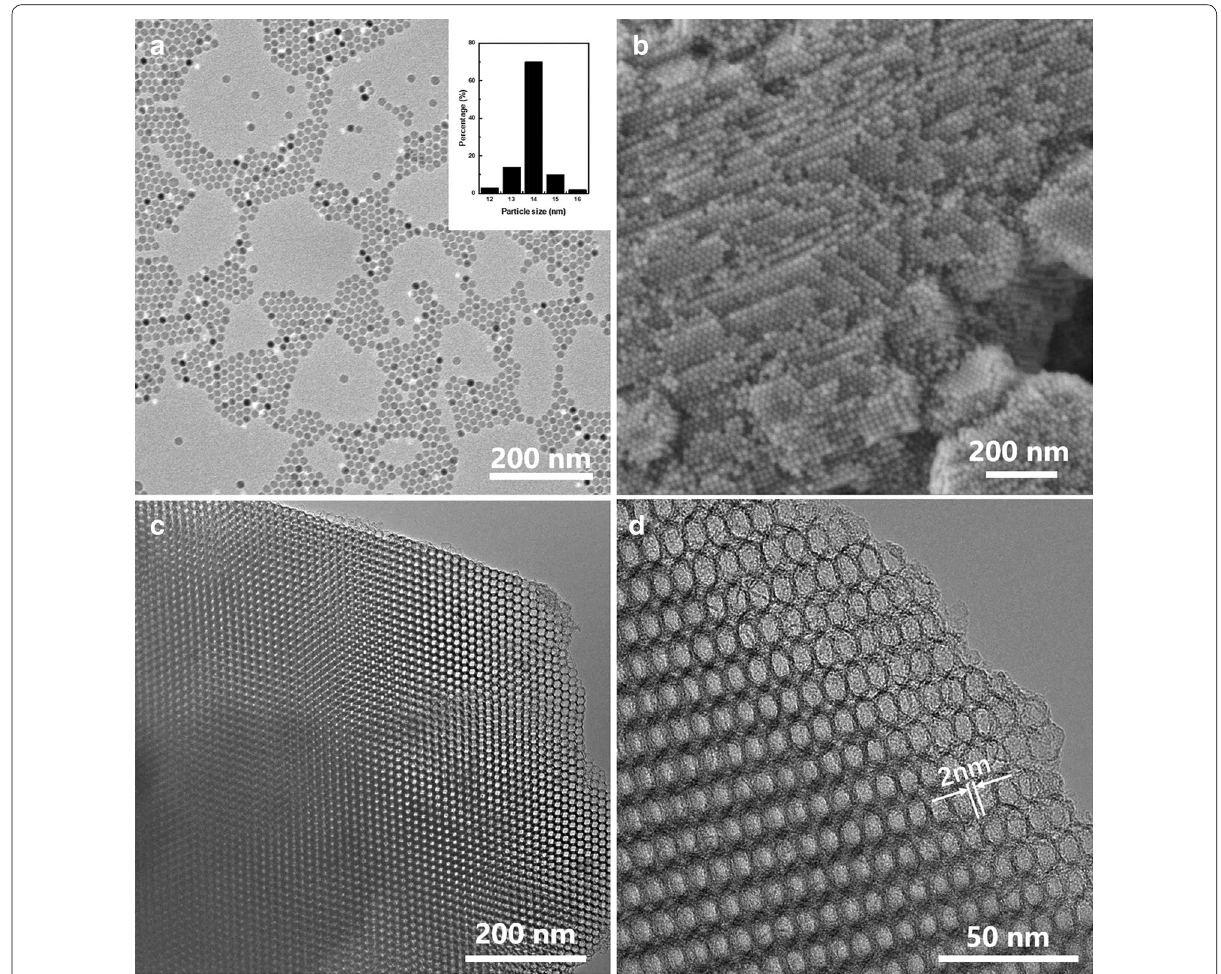
Fig. 1 a TEM image of monodispersed Fe 3 O 4 nanocrystals and size distribution analysis (insert). b SEM image of ordered Fe 3 O 4 superlattices via drying-induced self-assembly. c TEM image of ordered carbon frameworks after repeated acid treatment. d HRTEM image of Fe/CFs which illustrates the ultrathin interconnected spherical pore